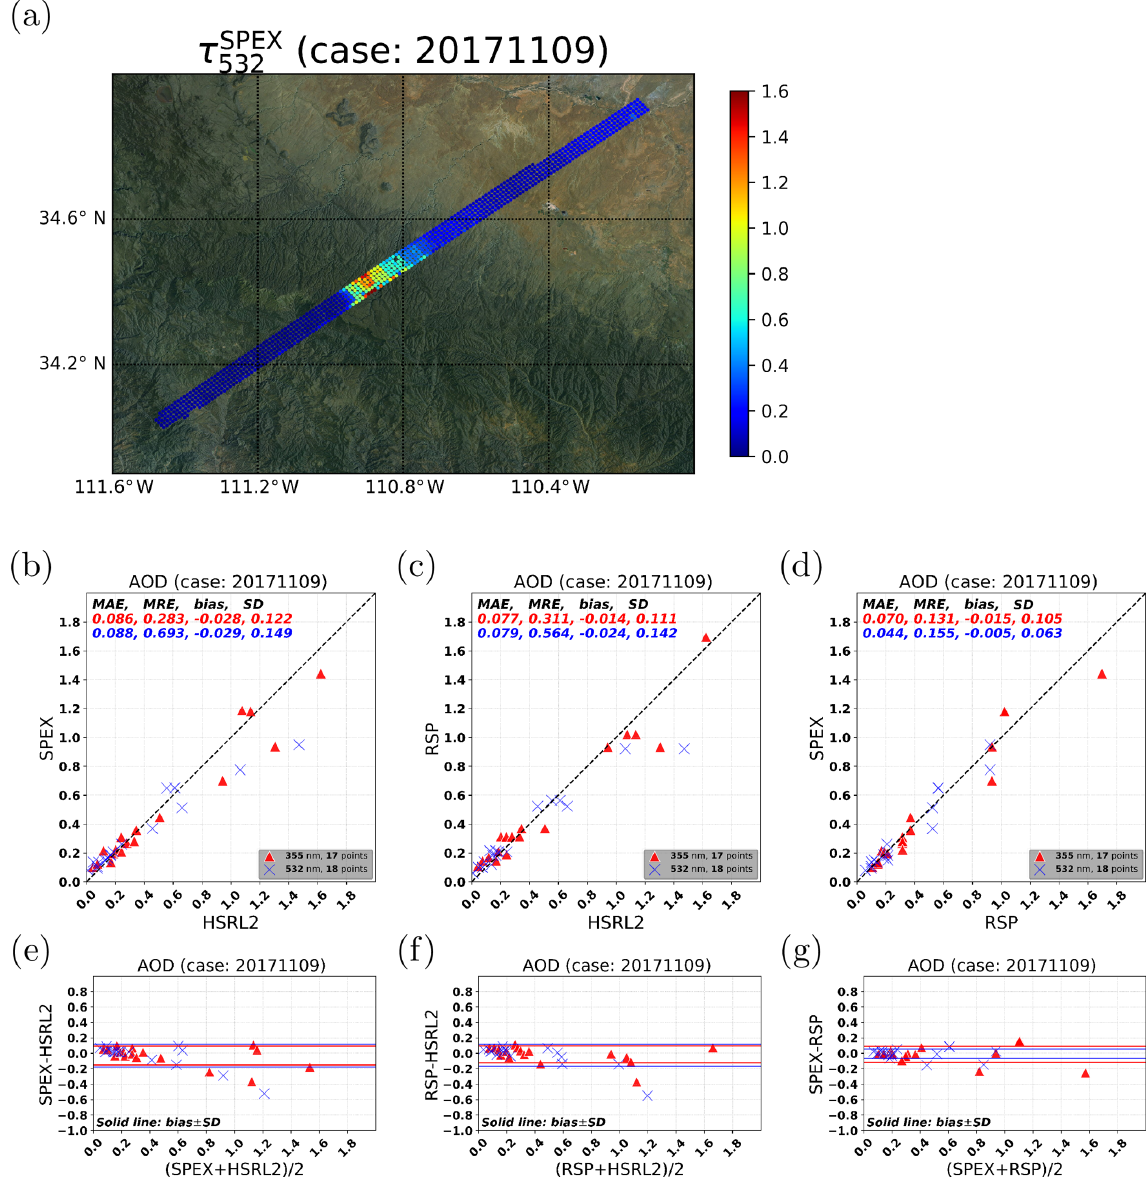
Figure 7. Comparison with HSRL-2 from 9 November 2017 (high AOD smoke case) for AOD (355 and 532nm) between SPEX and RSP retrievals. (a) SPEX original AOD, i.e., no filter or colocation included. (The map is generated using Python’s basemap package and its ArcGIS image service ESRI_Imagery_World_2D.) (b) SPEX AOD comparison with HSRL-2. (c) RSP AOD comparison with